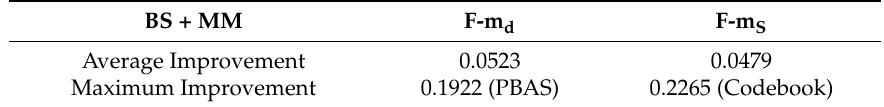
Table 15. Improvement of BS performance caused by median filter and morphological